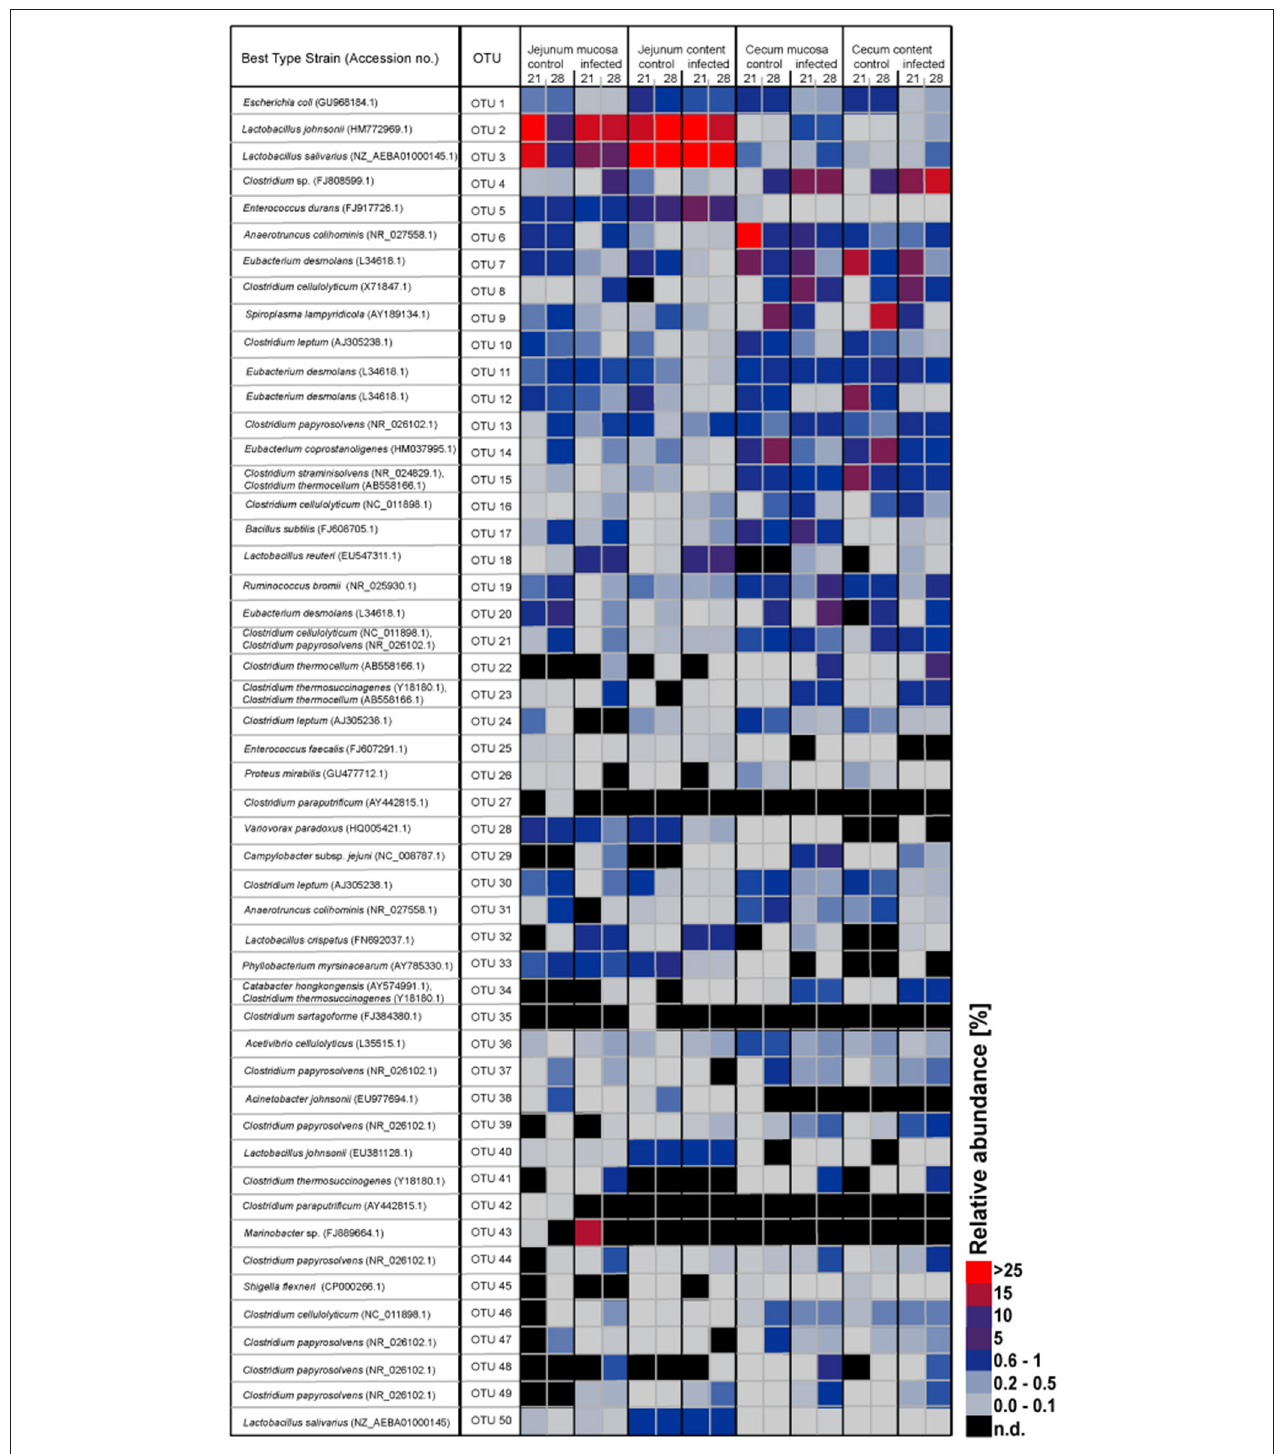
FIGURE 2 | Heatmap showing the relative abundances (%) of the 50 most-abundant OTUs sorted by gut sites of the infected birds compared with the controls at the two sampling points post infection. The heat map integrates relative abundance of a given phylotype. Colour scaling is ranged from 0 to ≥ 25%. n.d, not